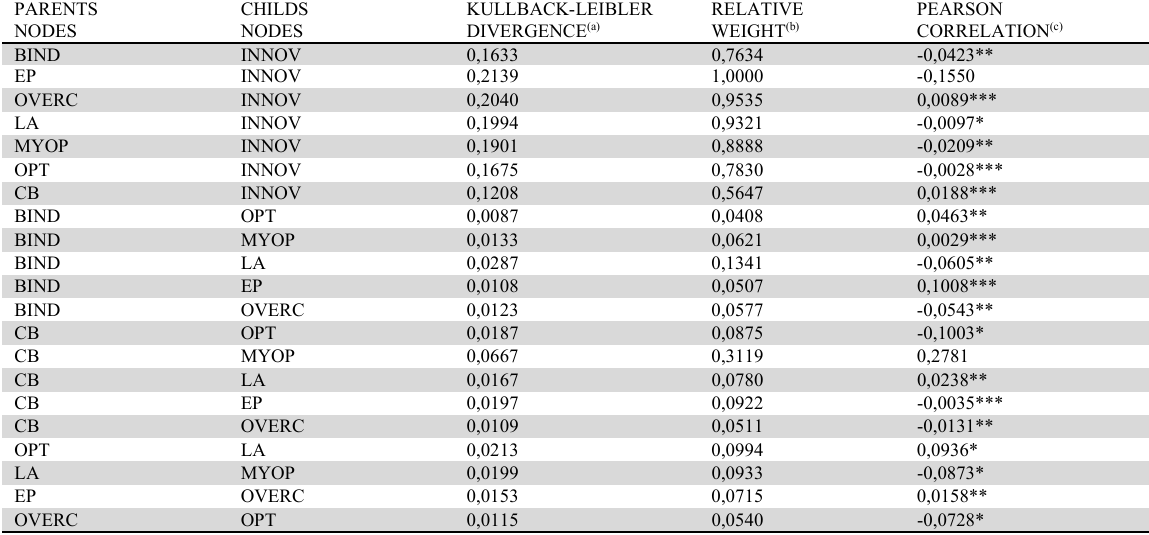
The relationships